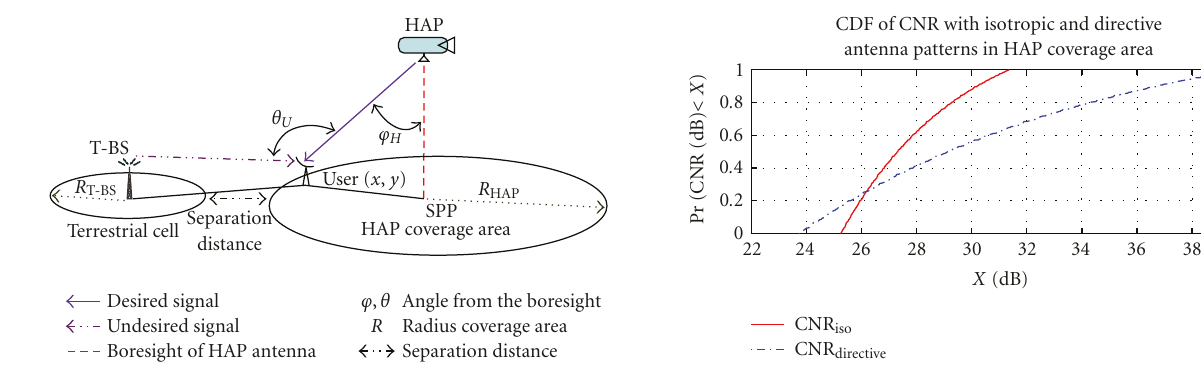
Figure 1: Coexistence model of providing WiMAX from a HAP and terrestrial base station.